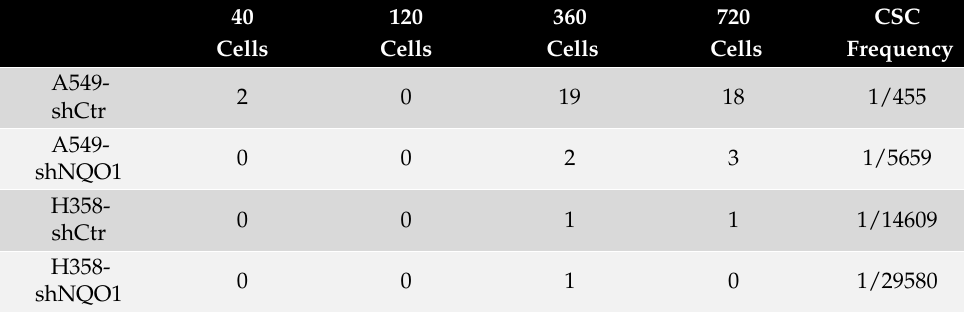
Table 1. Cancer stem cell frequency in A549 and H358 cells with or without shNQO1 expression. Quantification of the number of cancer stem cells present in the examined cell populations was carried out utilizing an in vitro extreme limited dilution assay. The assay required plating limited dilutions of cells in low attachment conditions and examining wells for spheroid formation. Wells with at least one spheroid were counted as a positive well for the corresponding dilution. The results were then analyzed using Extreme Limited Dilution Analysis (ELDA) software. The resulting CSC frequencies demonstrate a marked increase in the CSC population found in A549-shCtr and H358-shCtr in comparison to their respective shNQO1 cell lines. 40 120 360 720 CSC Cells Cells Cells Cells Frequency